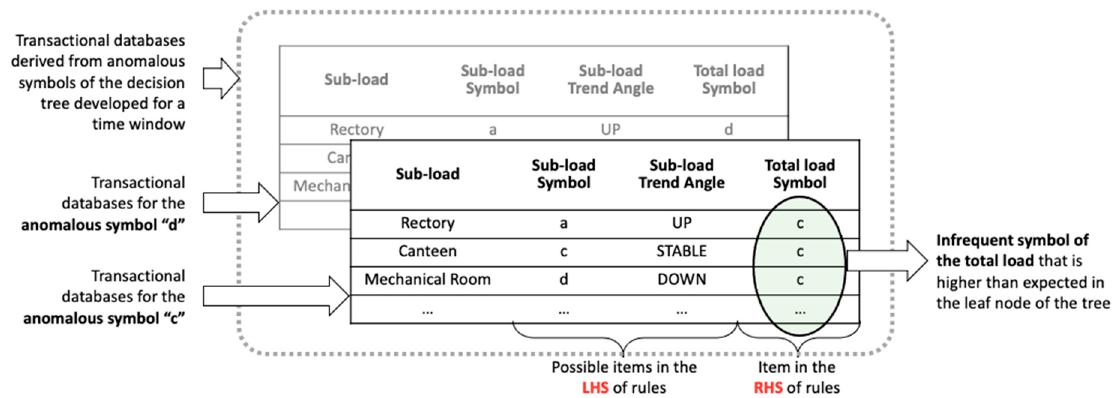
Figure 12. Representation of the transactional databases used for the extraction of association rules. LHS: left-hand side of the rule; RHS: right-hand side of the rule.